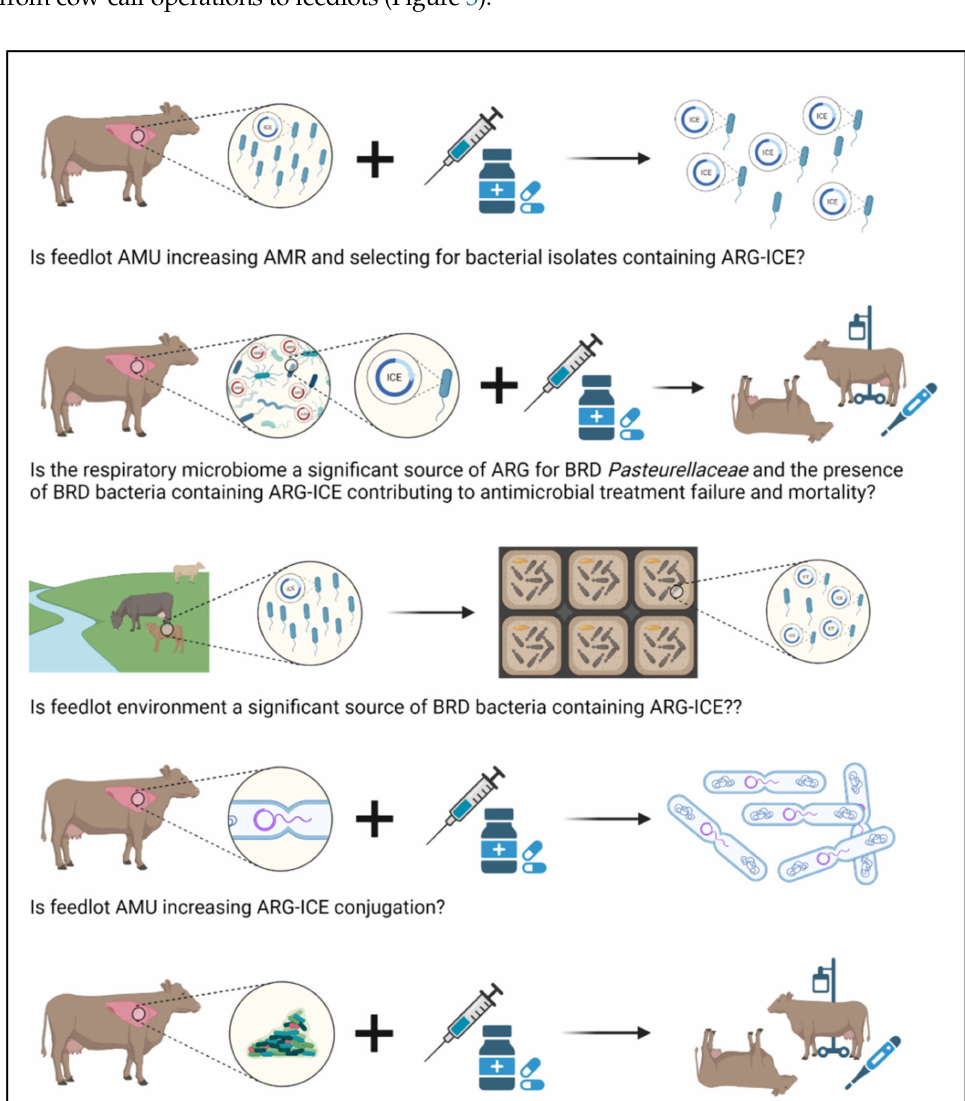
Figure 3. Main knowledge gaps related to antimicrobial resistance in bovine respiratory disease bacteria. ARG, antimicrobial resistance gene; ARG-ICE, integrative and conjugative elements linked to antimicrobial resistance genes; AMU, antimicrobial use; BRD, bovine respiratory disease. Created with